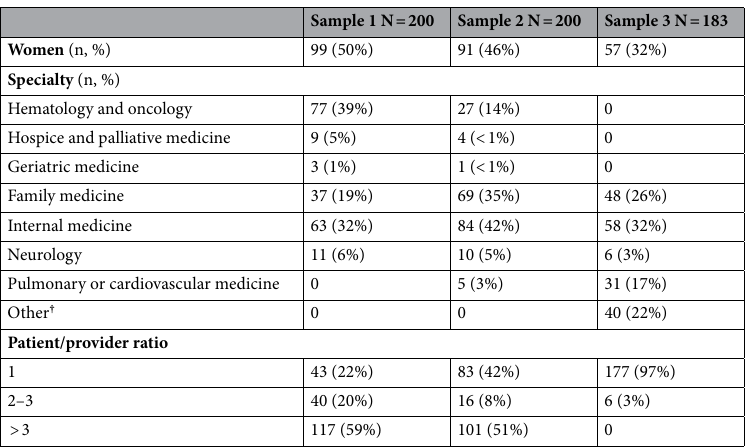
Table 2. Characteristics of clinicians surveyed, N = 583. † Other specialty includes: allergy & immunology, general surgery, infectious disease, obstetrics & gynecology, occupational medicine, pain medicine, psychiatry, sports medicine, surgical critical care,